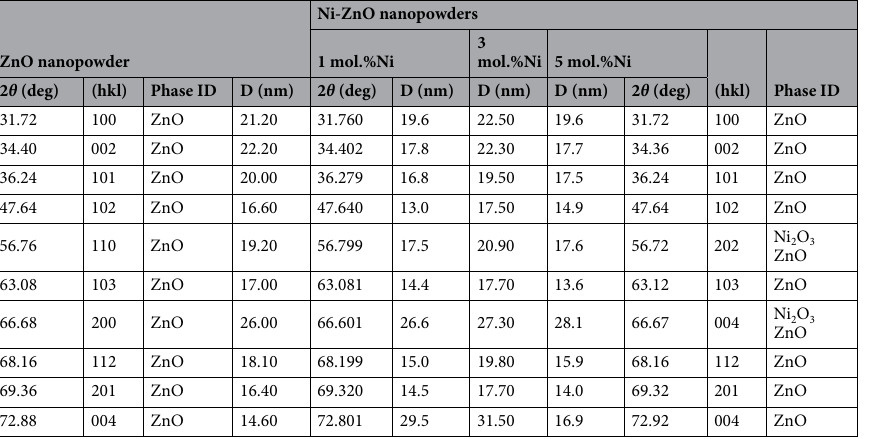
Table 1. 2 θ , hkl , phase ID and crystallite size ( D ) of pure ZnO and Ni doped ZnO nanopowders as presented in XRD patterns analysis.